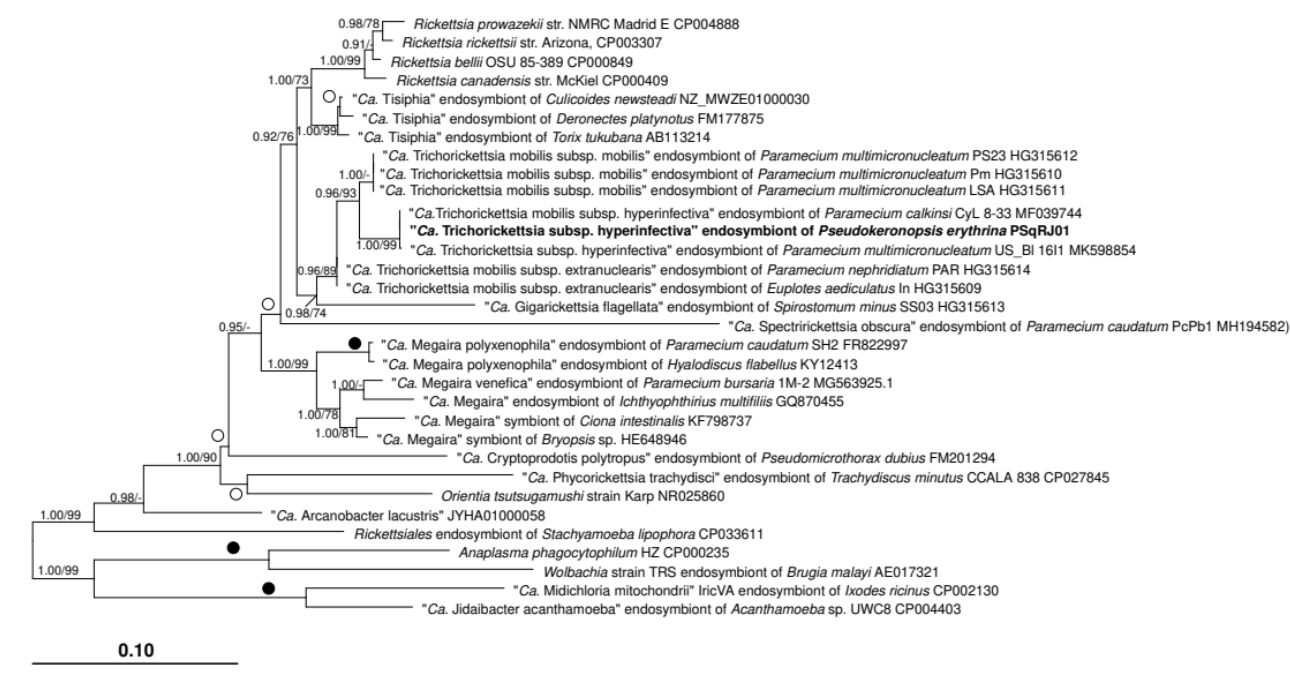
Figure 4. Maximum likelihood tree of the family Rickettsiaceae based on 16S rDNA sequences. The phylogenetic position of the bacterial symbiont of Pseudokeronopsis cfr. erythrina PSqRJ01 is shown. Numbers associated with nodes represent posterior probability from BI and bootstrap value from ML analyses, respectively (only values of BI ≥ 0.80 and ML ≥ 70% are shown). Black dots represent the highest statistical support (BI = 1.00 and ML = 100); white dots indicate non-significant statistical support (BI < 0.80 and ML < 70%). The sequence obtained in the present work is in bold.